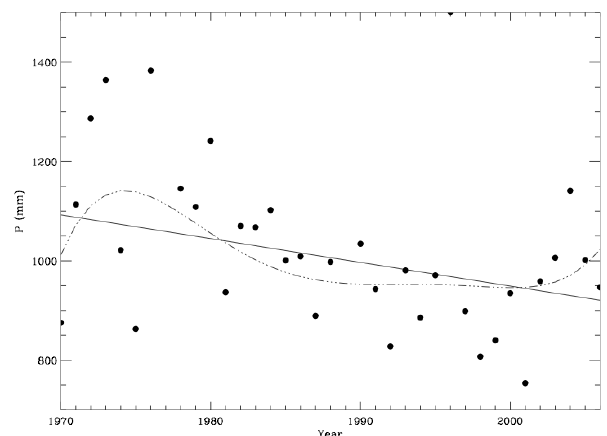
Fig. 2b. Linear trend of the yearly rainfall over Calabria. A fifth- order polynomial fitting is also shown. Among polynomials from the first to seventh degree, the fifth order minimizes the sum of squared differences between the interpolating curve and the orig- inal time